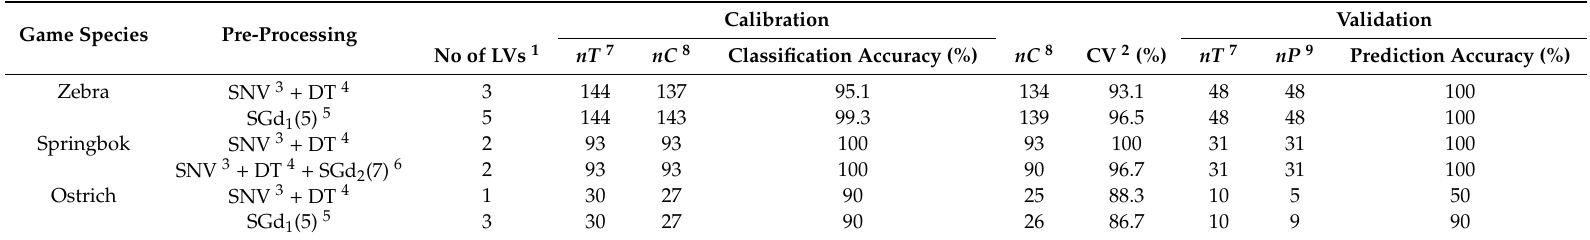
Table 2. An overview of the accuracies of the PLS-DA models with various pre-processing techniques applied to distinguish between fresh or previously frozen meat. Game